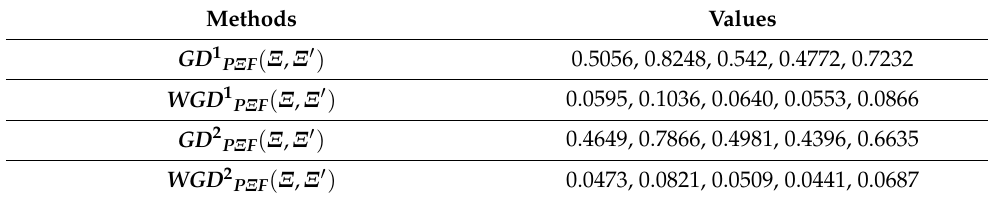
Table 1. Expressions of the measured values by using different measures.